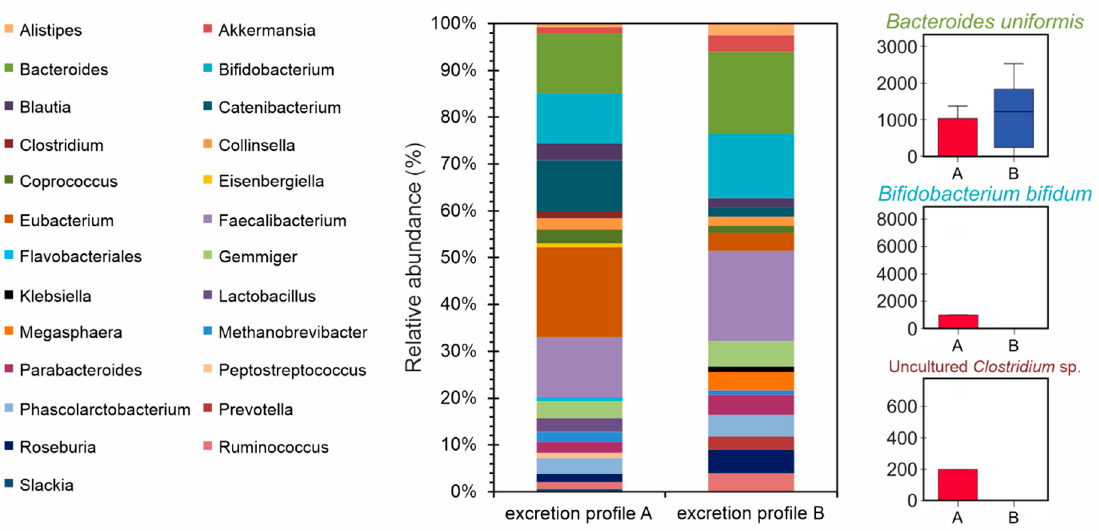
Figure 6. Relative abundance of gut microbiota genera in volunteers with Excretion Profiles A (n = 5) and B (n = 10).